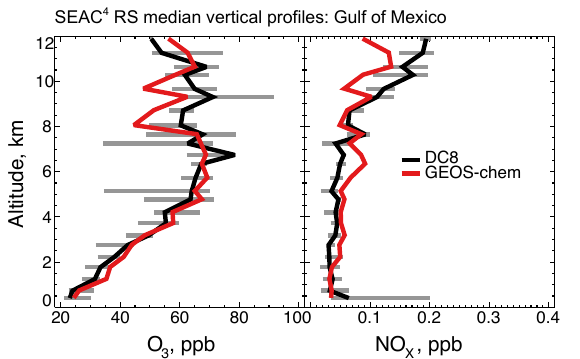
Figure 11. Median vertical profiles of ozone and NO x concentra- tions over the Gulf of Mexico during SEAC 4 RS. Observations are from four SEAC 4 RS flights over the Gulf of Mexico (12 August and 4, 13, 16 September). GEOS-Chem model values are sampled along the flight tracks. The 25th and 75th percentiles of the aircraft observations are shown as horizontal bars.